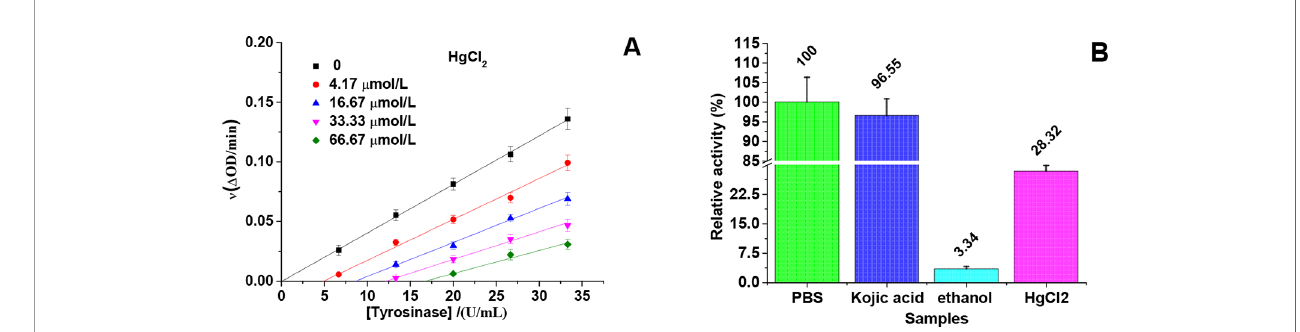
FIGURE 3 | Inhibition mechanism of HgCl 2 on tyrosinase. (A) An irreversible inhibition of the enzyme on a kinetic basis: the concentrations of HgCl 2 were 0, 4.17, 16.67, 33.33, and 66.67 m mol/L for curves, and the concentrations of tyrosinase were 6.67, 13.33, 20, 26.67, and 33.33 U/mL. (B) Immobilized tyrosinase for analysis of inhibitory mechanism: As a negative control, the activity of tyrosinase with PBS treatment was de fi ned as 100%, and the concentration of kojic acid and HgCl